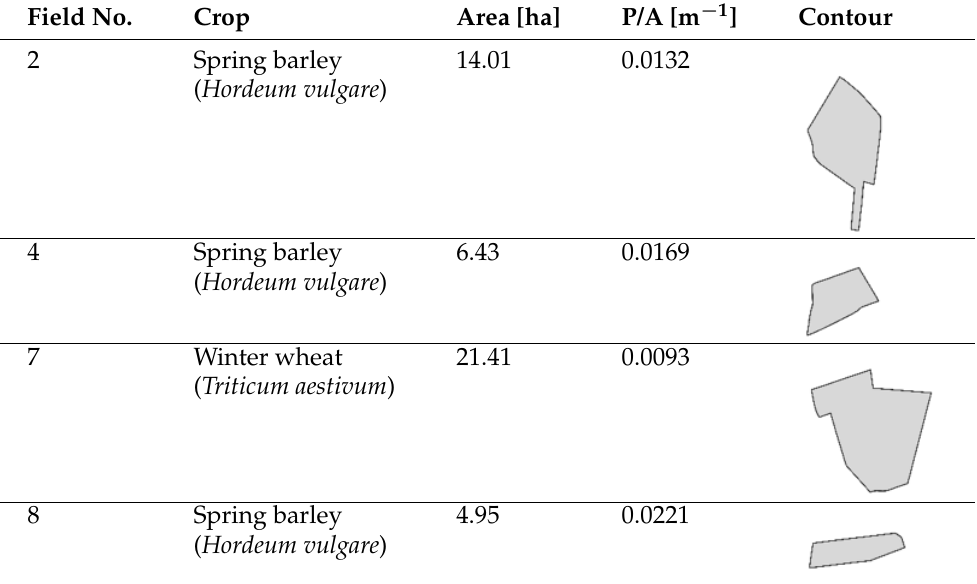
Table 1. Geometric data for the seven case study fields including perimeter (m)-to-area (m 2 ) ratio (P/A, m − 1 ) and field